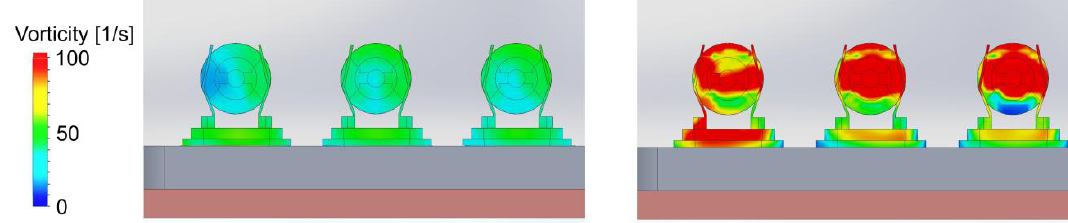
Figure 12. Detailed comparison of the vorticity at the quartz surface of Figures 6 and 7. The left simulation shows the vortex on the quartz surface of the measurement tube with LFE. On the right the simulation of the measurement system without LFE is displayed.